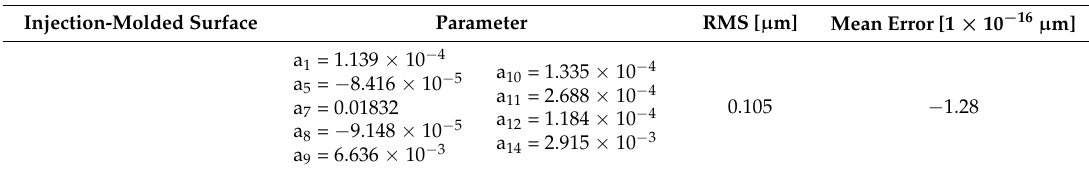
Table 1. Fitted function and its parameters. RMS and mean error describe the fit accuracy with respect to the measured